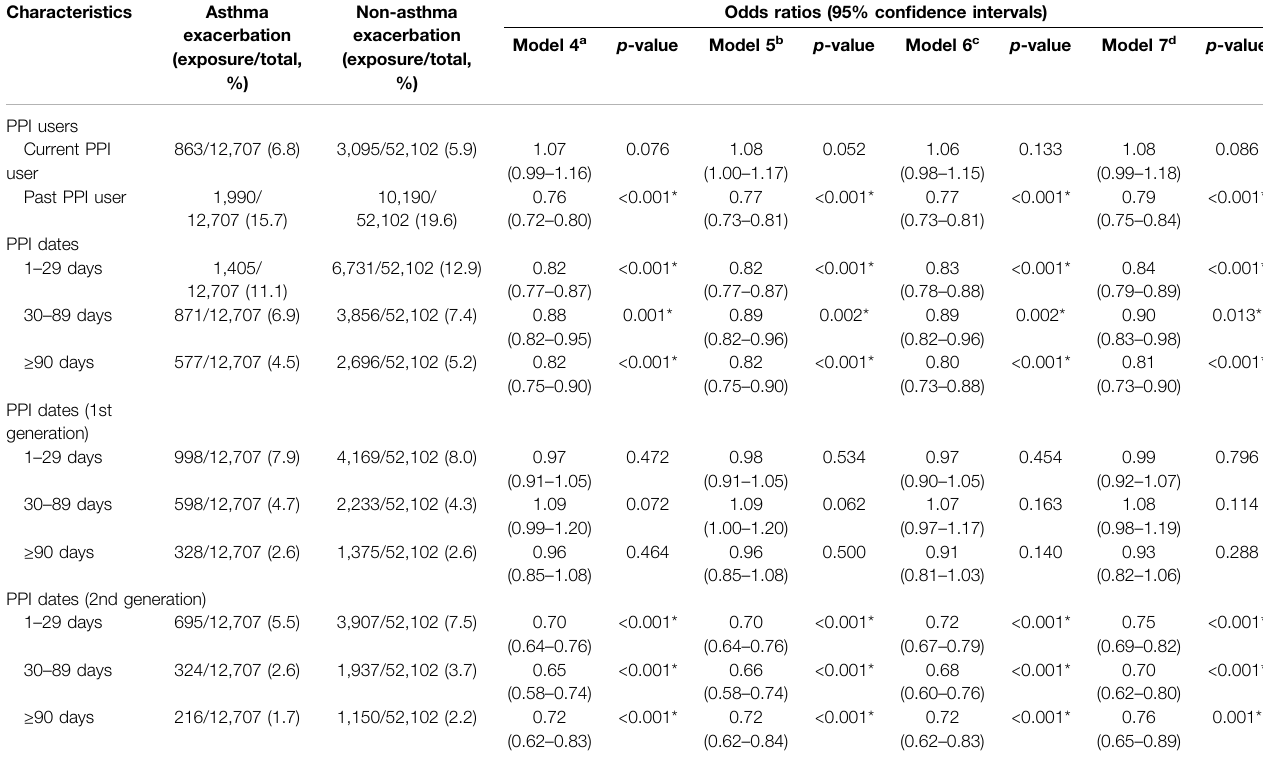
TABLE 4 | Odds ratios (95% con fi dence intervals) of PPI prescription history/PPI prescription dates/prescription dates of each generation of PPI for asthma exacerbation. Characteristics